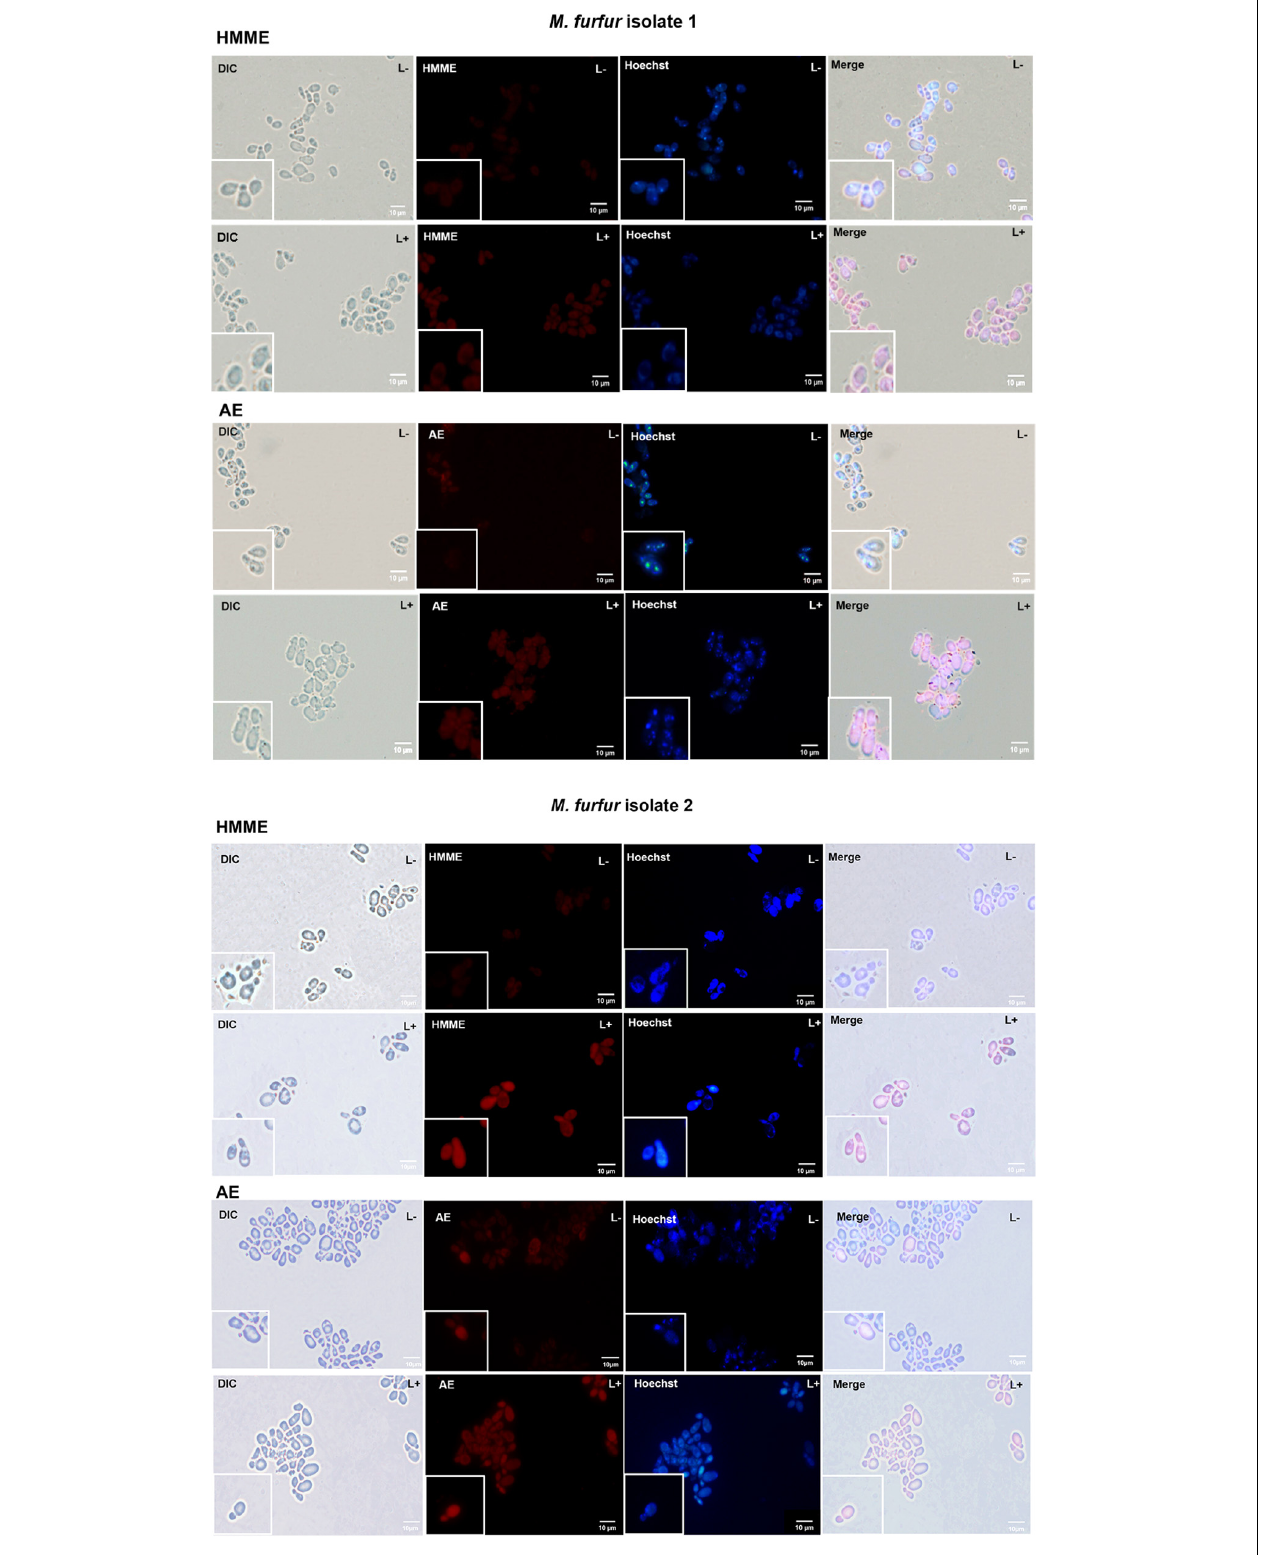
FIGURE 6 | Fluorescence images of M. furfur cells after HMME and AE-mediated aPDT. (L–) represents the M. furfur cells treated with 10 µ M of PSs; (L+) represents the M. furfur cells treated with 10 µ M of PSs and irradiated with 72 J cm − 2 of light.